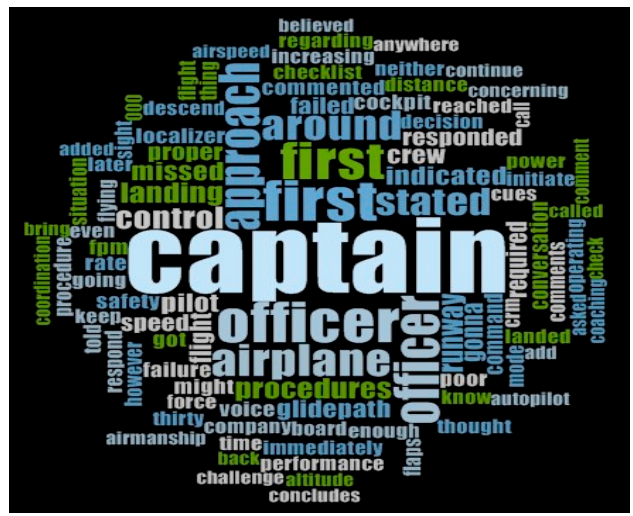
Table 11. Examples of CRM issues as contributing factors.